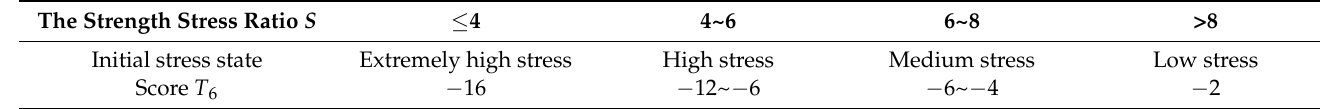
Table 12. Score of the initial stress